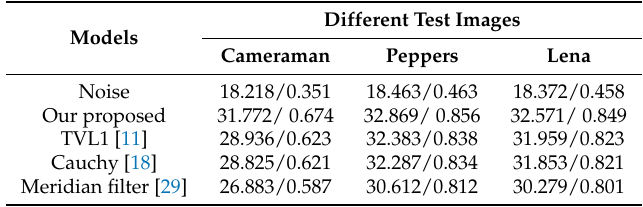
Table 1. The PSNR (dB)/SSIM for noisy images and recovered